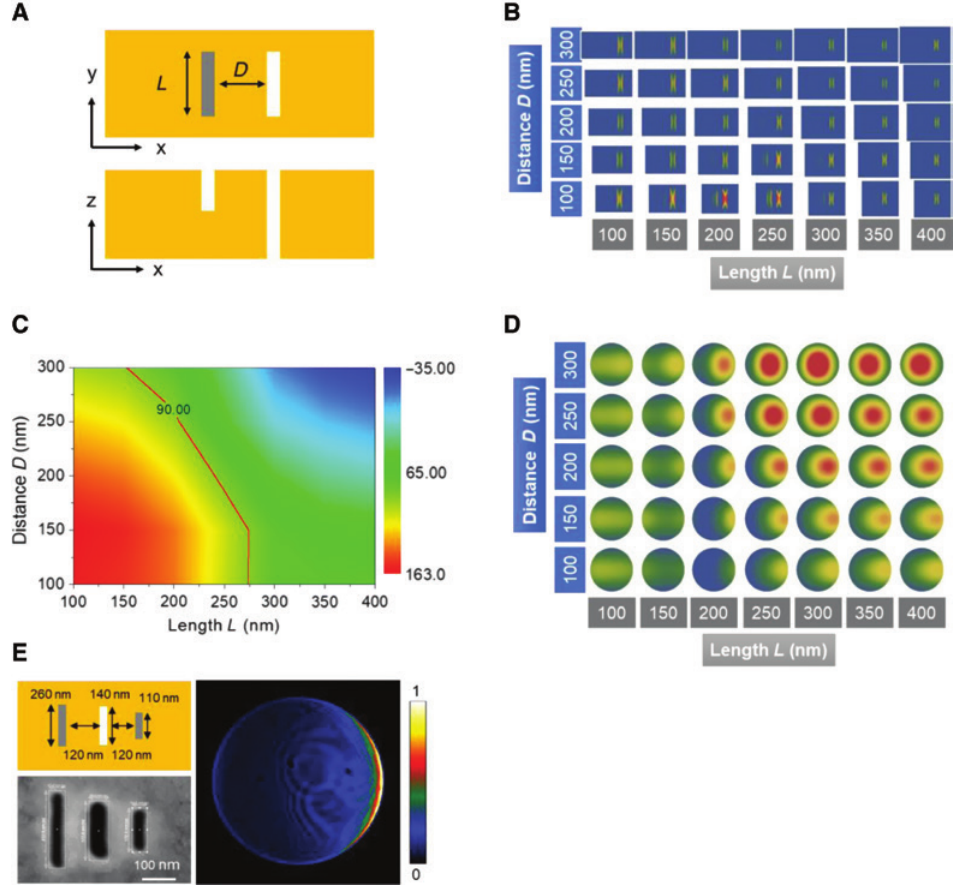
Figure 11: Optical slot-groove Yagi-Uda antennas. (A) Schematics of the slot-groove geometry. L and D correspond to the length of the groove and the distance from the slot, respectively. (B) E -field intensities calculated by 3D-FDTD while changing L and D . The intensities are normalized by the maximum intensity. (C) Contour x map of phase difference calculated by 3D-FDTD while changing L and D . The scale bar shows the phase difference between the slot-groove in degrees. The red line corresponds to 90 ° phase difference. (D) Far-field radiation patterns calculated by 3D-FDTD while changing L and D . The intensities are normalized by the maximum intensity. (E) Schematics (top left) and SEM image (bottom left) of fabricated groove-slot- groove directional antenna and measured far-field radiation pattern of the fabricated sample (right). The white bar in SEM corresponds to 100 nm and the intensity of far-field radiation pattern is normalized by its maximum